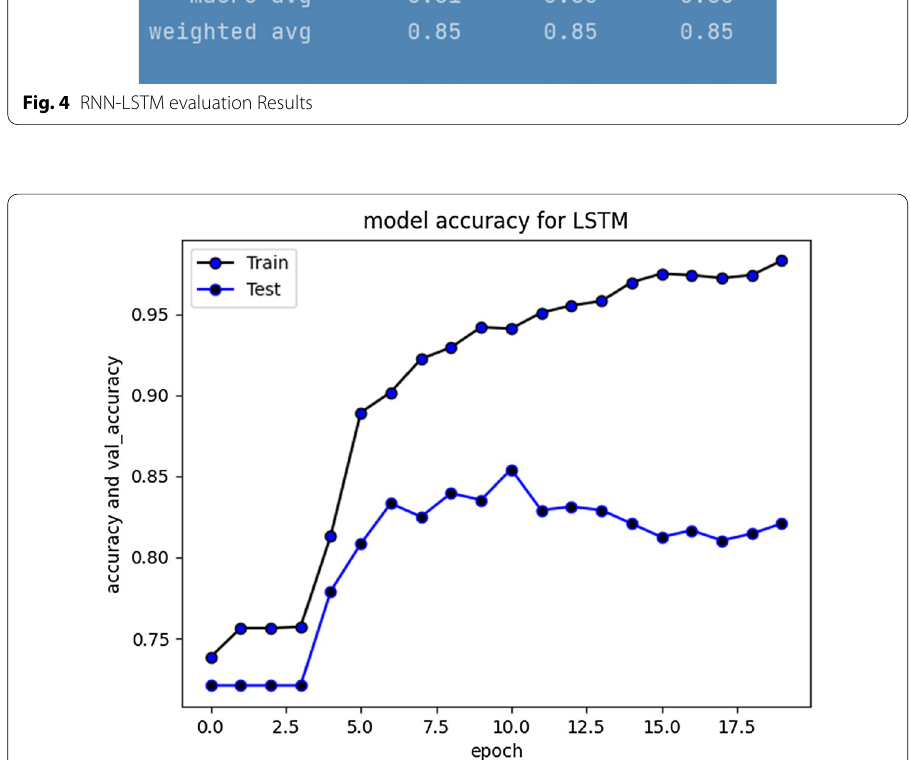
Fig. 5 RNN-LSTM Model accuracy graph for 20